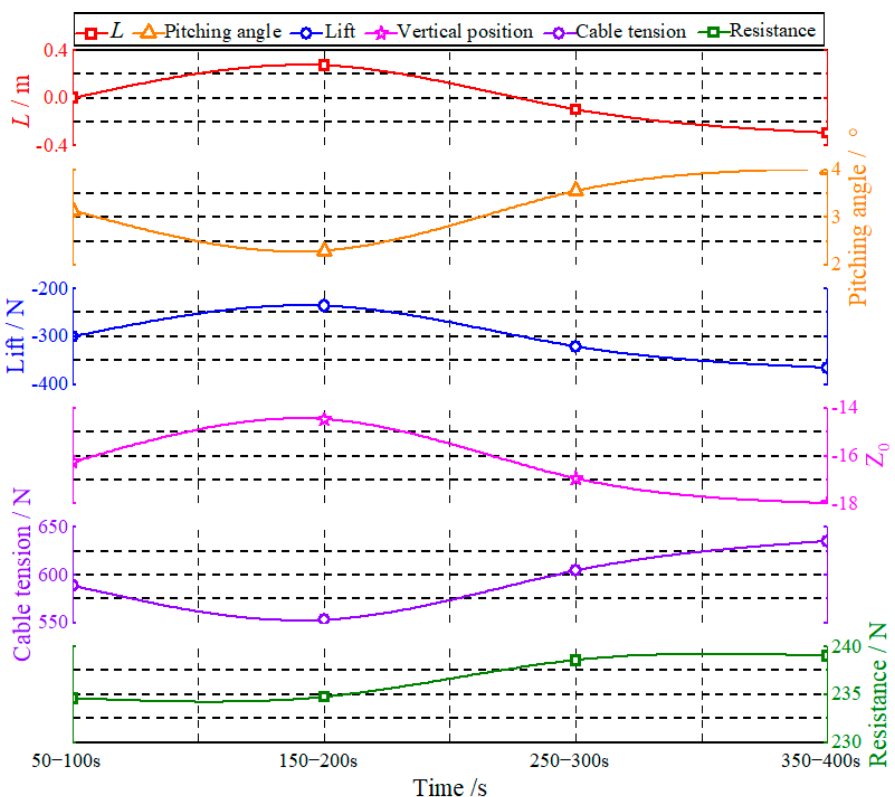
Figure 20. Mean value of steady-state parameters of the towed system in different stages.